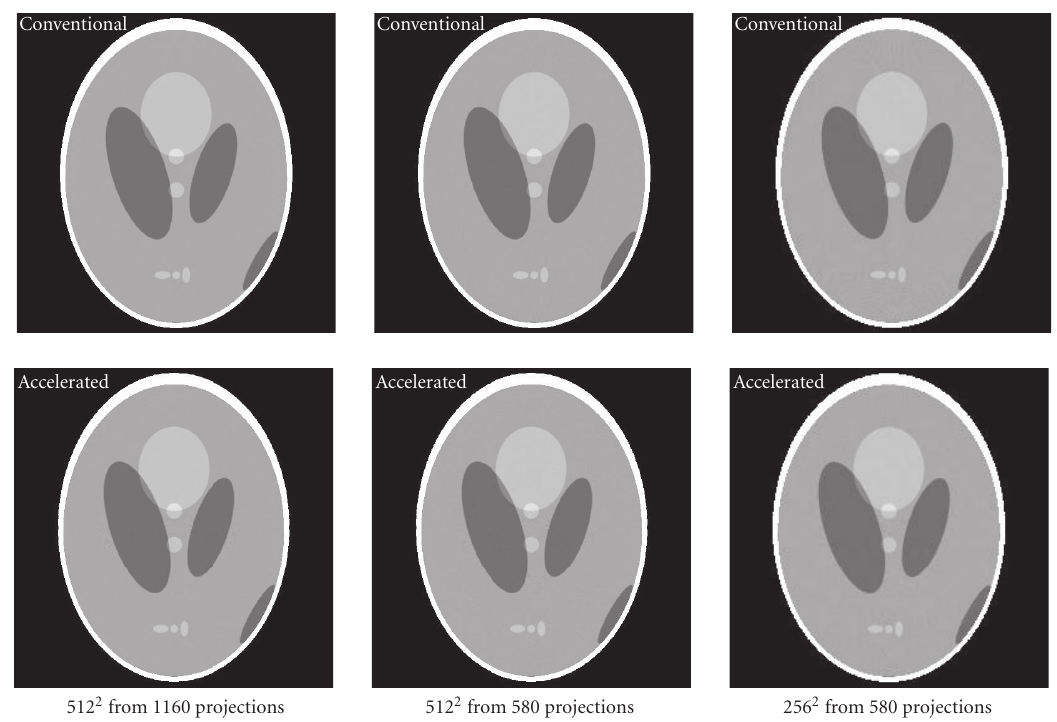
Figure 11: Reconstructed images of the Shepp-Logan using the conventional and accelerated codes (2 threads) in the display window [0 . 97,1 .